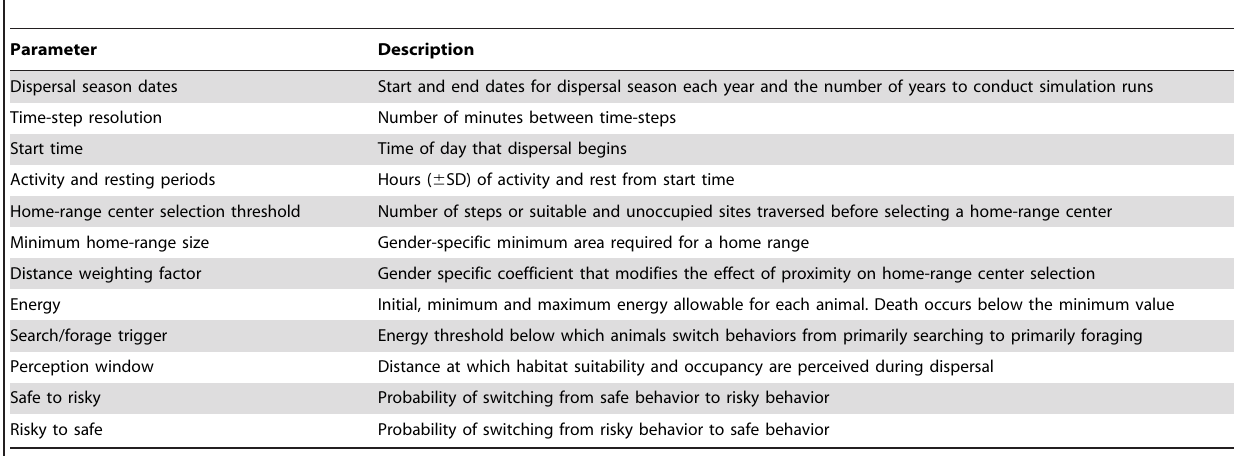
Table 2. Animal parameter values input by the user for the temporal aspects of the simulation along with basic attributes of virtual animals.